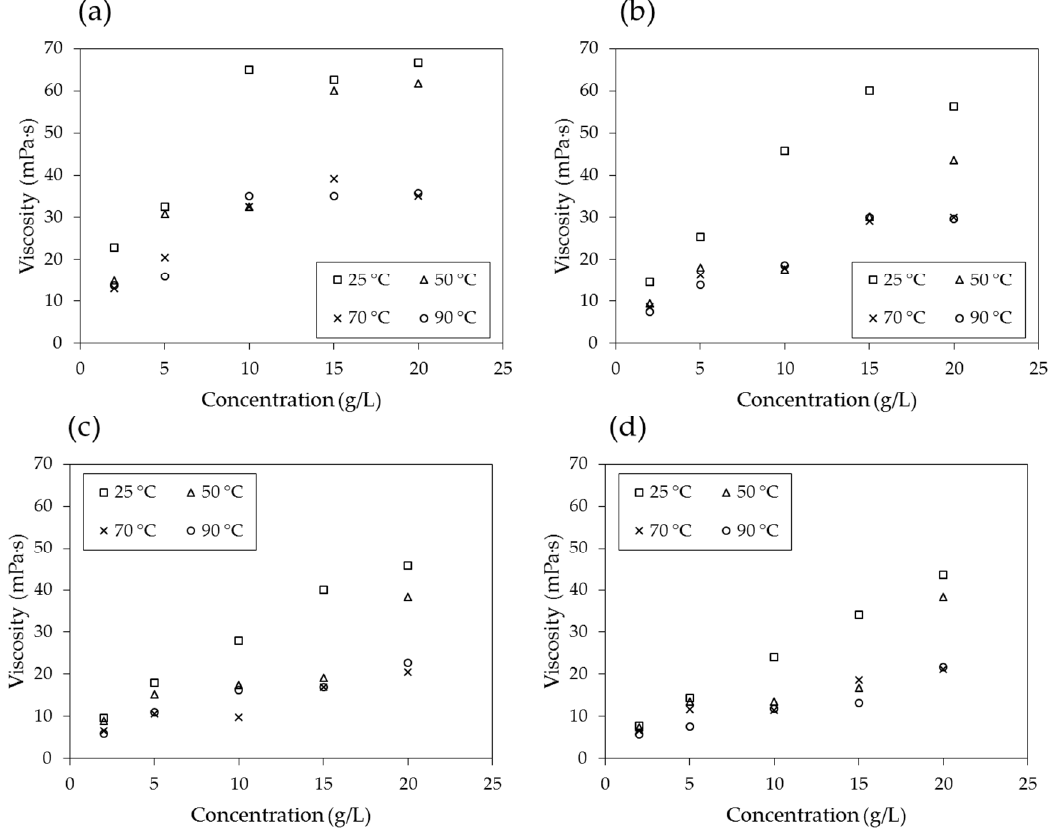
Figure 8. Cont. Figure 8.